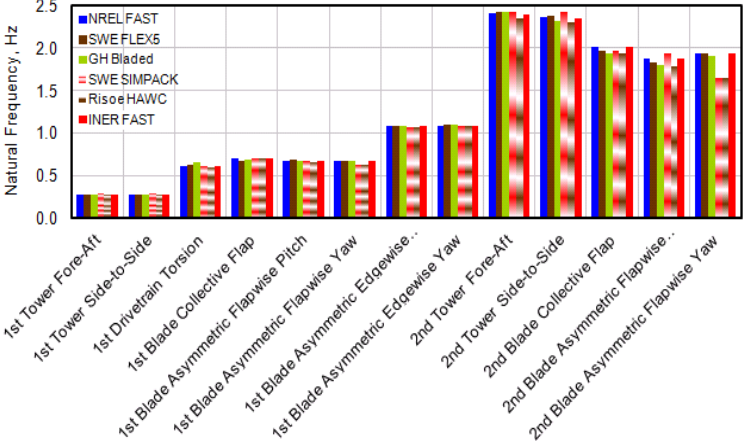
Figure 3. Full System Natural Frequencies under Load Case 1.2 of OC3 Phase I.